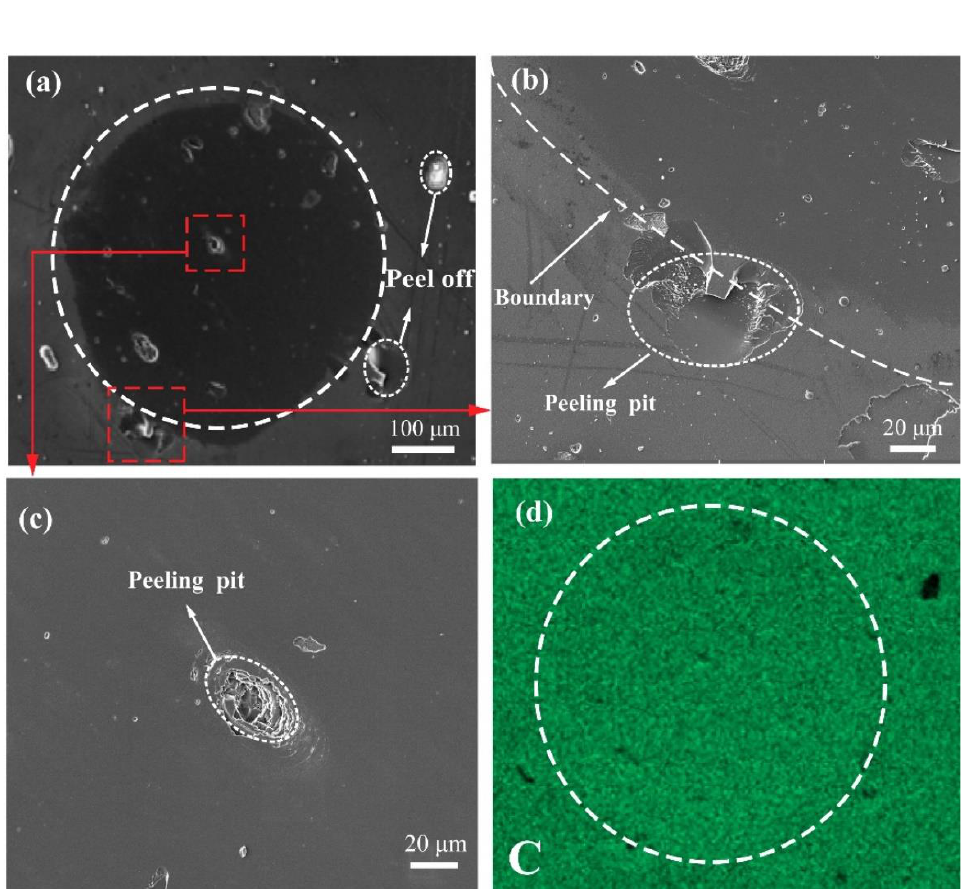
Figure 9. Wear scar topography and elemental distribution of Cr/W-DLC/DLC multilayer films at 500 °C under no-sand condition: ( a – c ) wear scar topography; ( d ) elemental distribution.